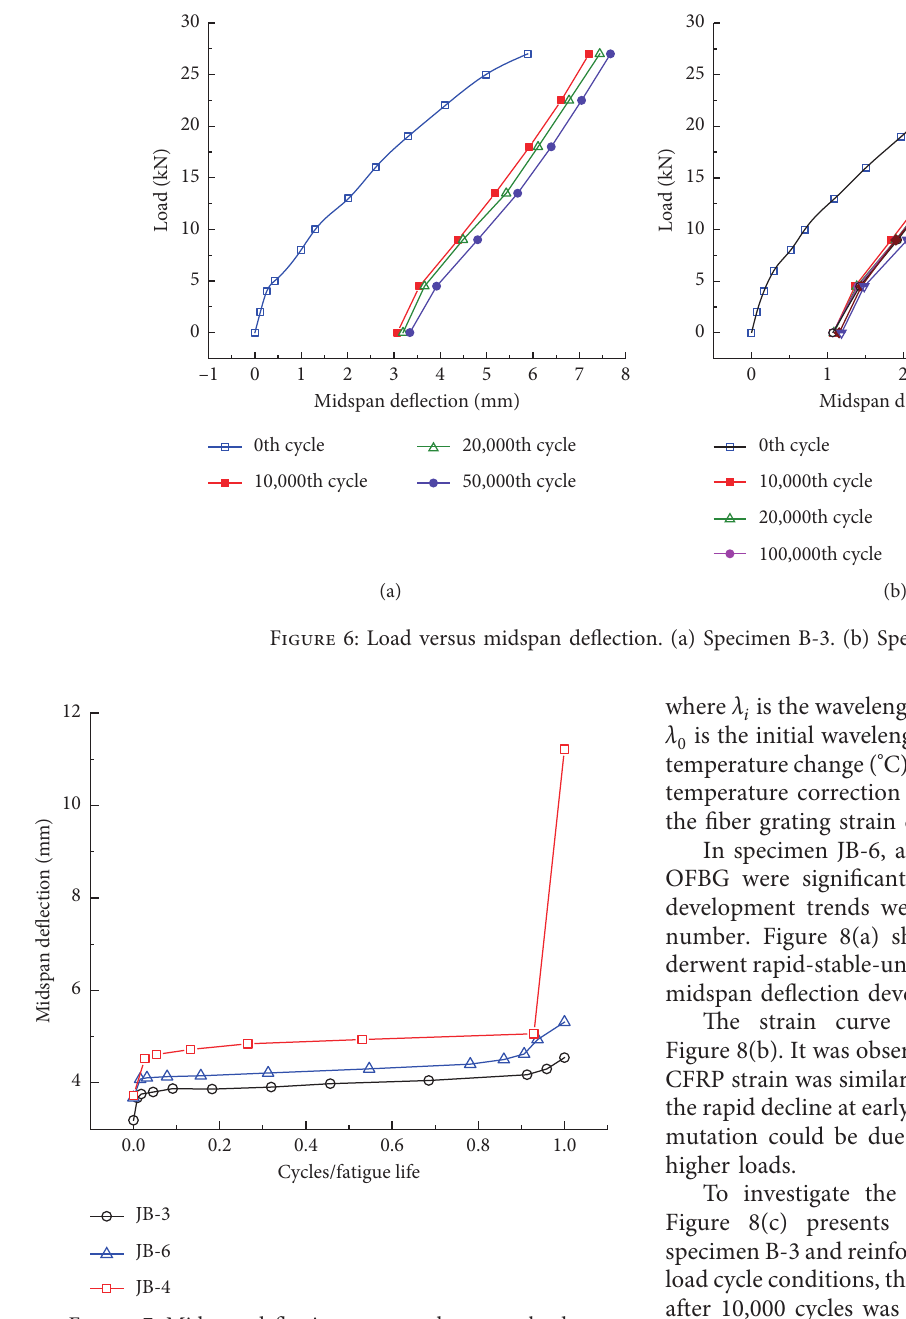
Figure 7: Midspan deflection curve under upper